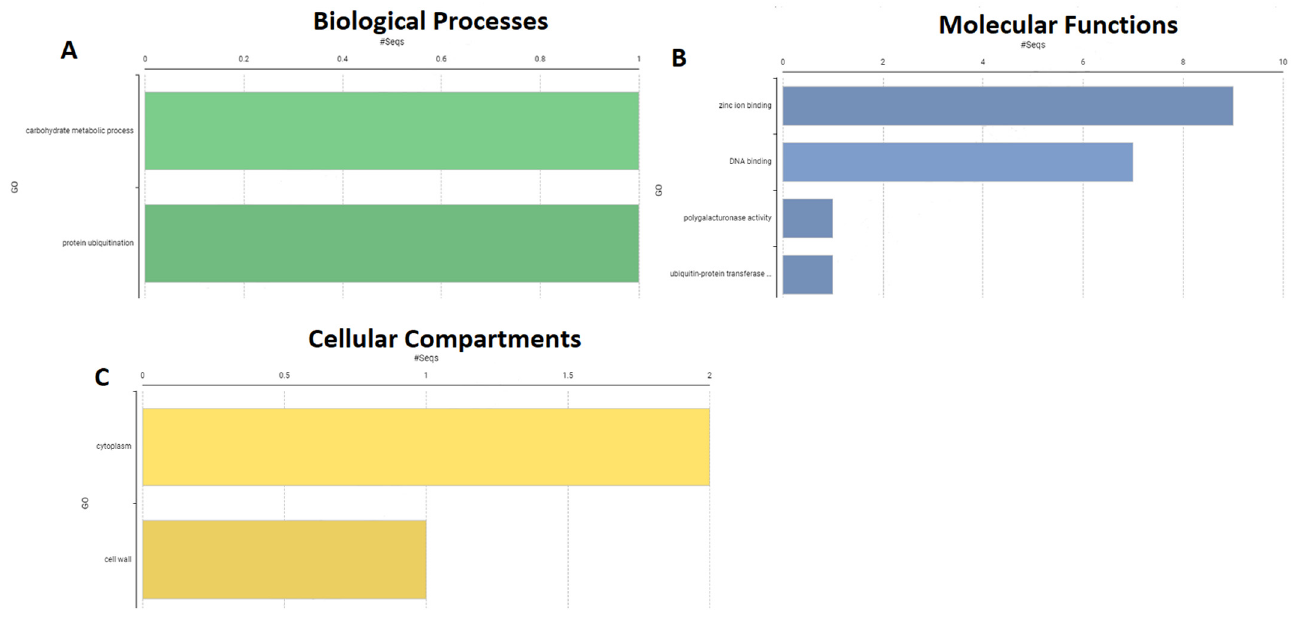
Figure 9. Gene ontology of PdSAP genes by Blast2GO. Green bars indicated biological processes ( A ), blue bars indicate molecular functions of PdSAP ( B ), and yellow bars indicate the presence of PdSAP in cellular compartments ( C